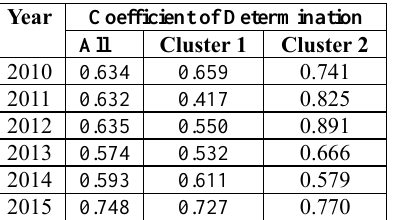
Table 9. Coefficient of Determination from OLS regression of Cluster 1 and Cluster 2 for each year and whole period using the significant predictors of 2010 – 2015 whole